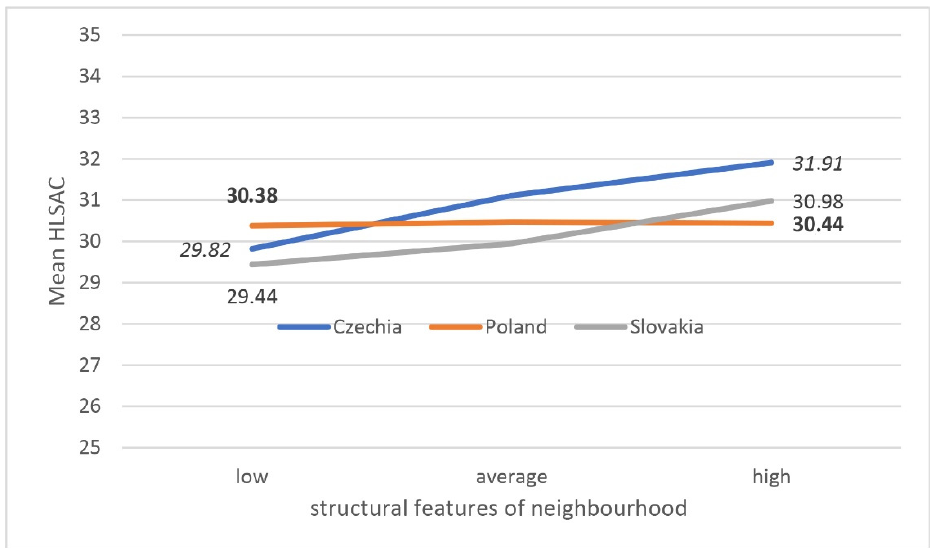
Figure 2. Average health literacy in school aged children (HLSAC) level by country and structural neighbourhood features (adjusted for gender, age, social features, and family affluence